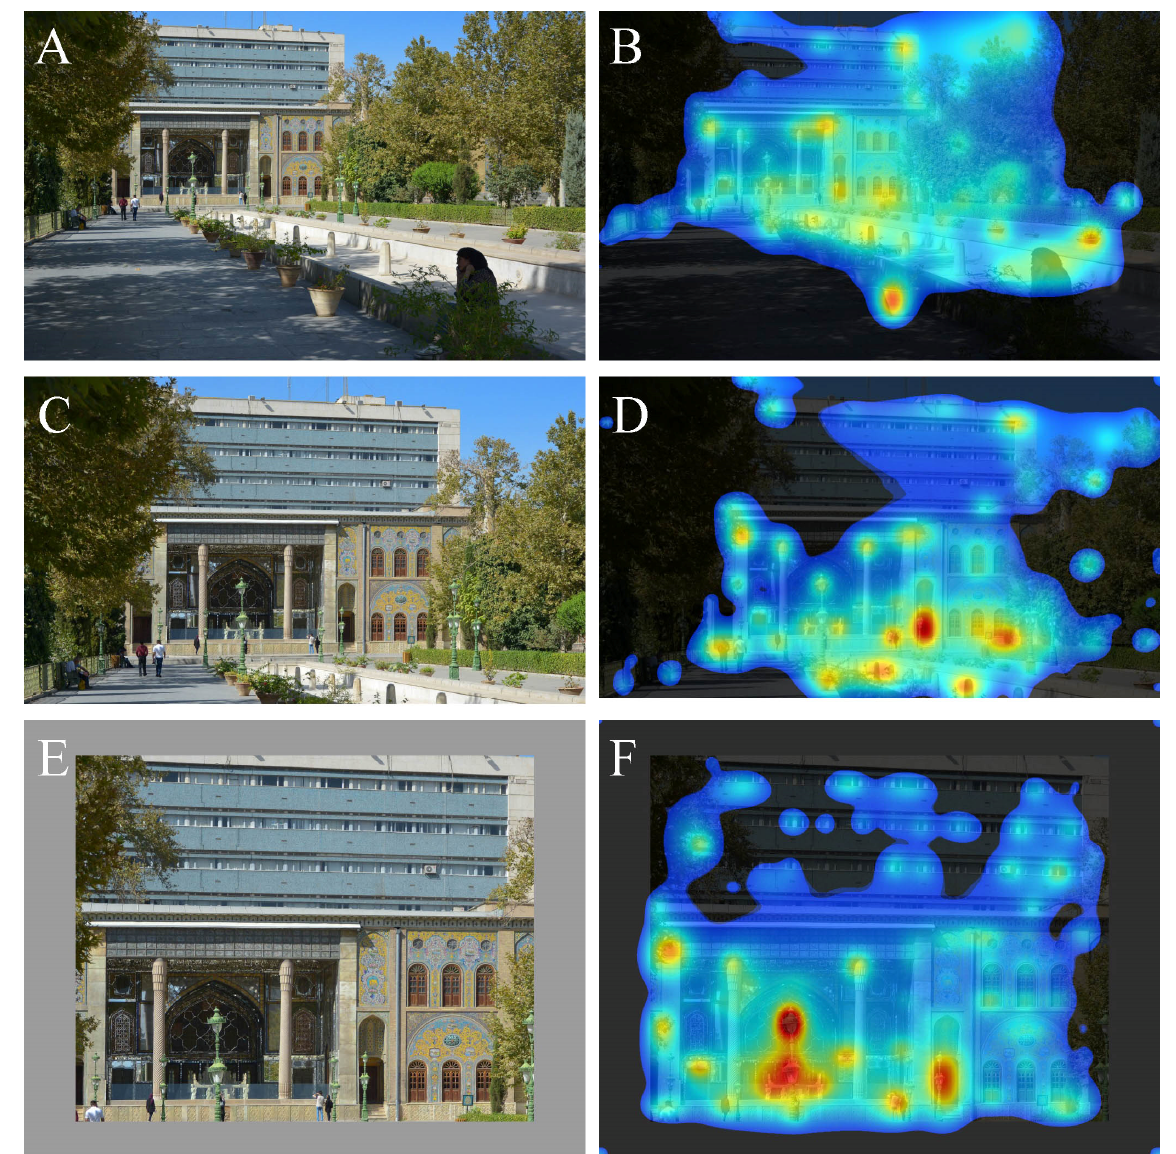
Figure 7. ( A ) The Royal Balcony with the Marble throne, from the 18th century, one of the buildings of the Golestan Palace complex in Tehran, Iran. This building is near the border of the complex, and a tall modernist-style office building can be seen from across the street behind it. ( B ) Eye-tracking simulation heatmap of the ensemble. ( C , D ) and ( E , F ): Zoomed-in views with their new heatmaps.